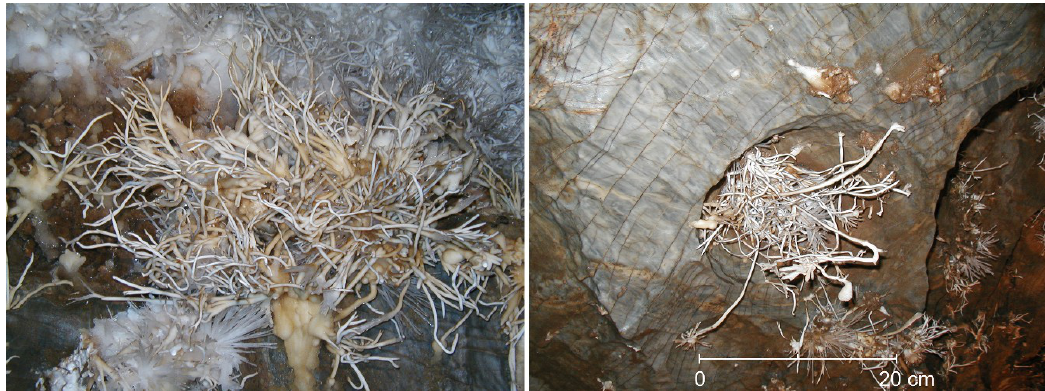
Figure 3. Aragonite formations, Ochtiná Aragonite Cave.